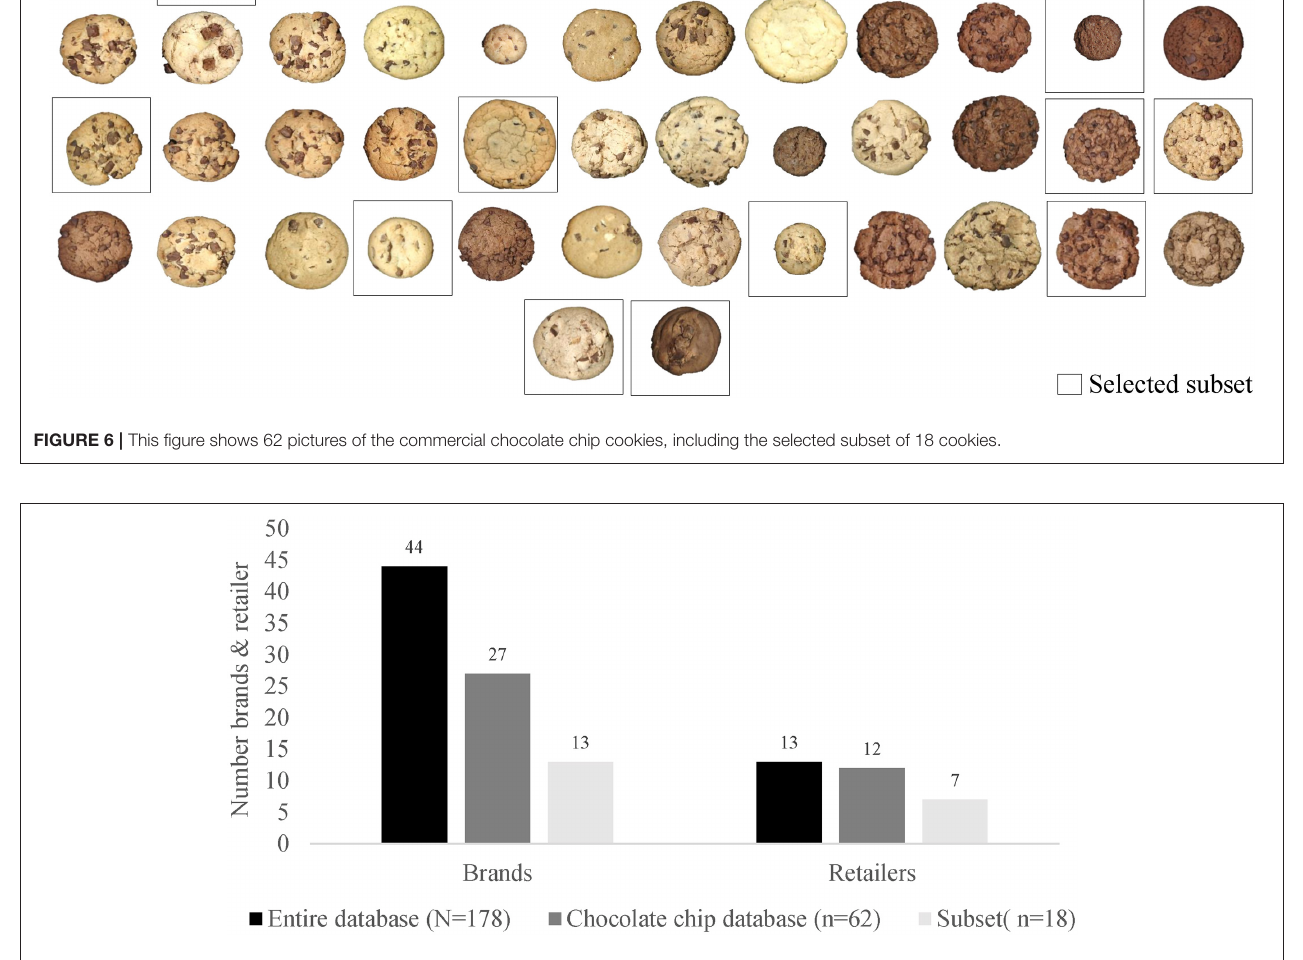
FIGURE 7 | Representativity of the brands and retailers of the selected subset.